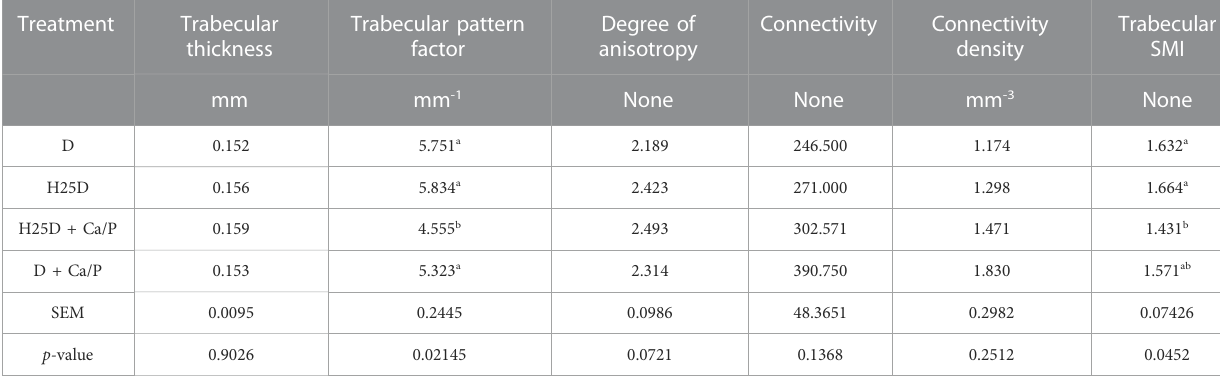
TABLE 8 Micro-CT results for trabecular bone structural